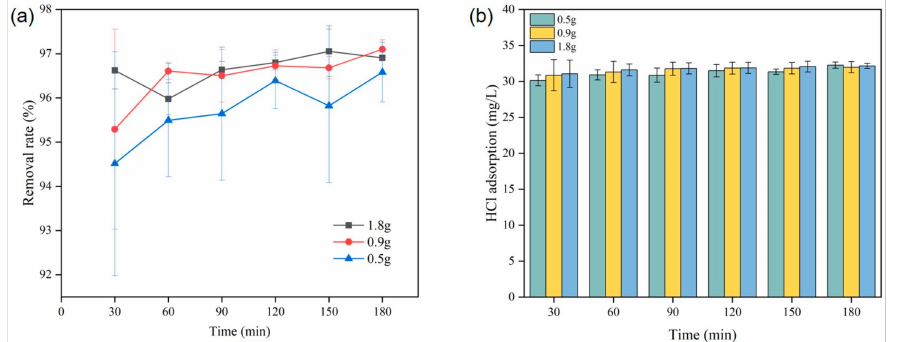
Figure 2. Effect of different space velocity ratios on ( a ) HCl removal rate (%) and ( b ) HCl adsorption